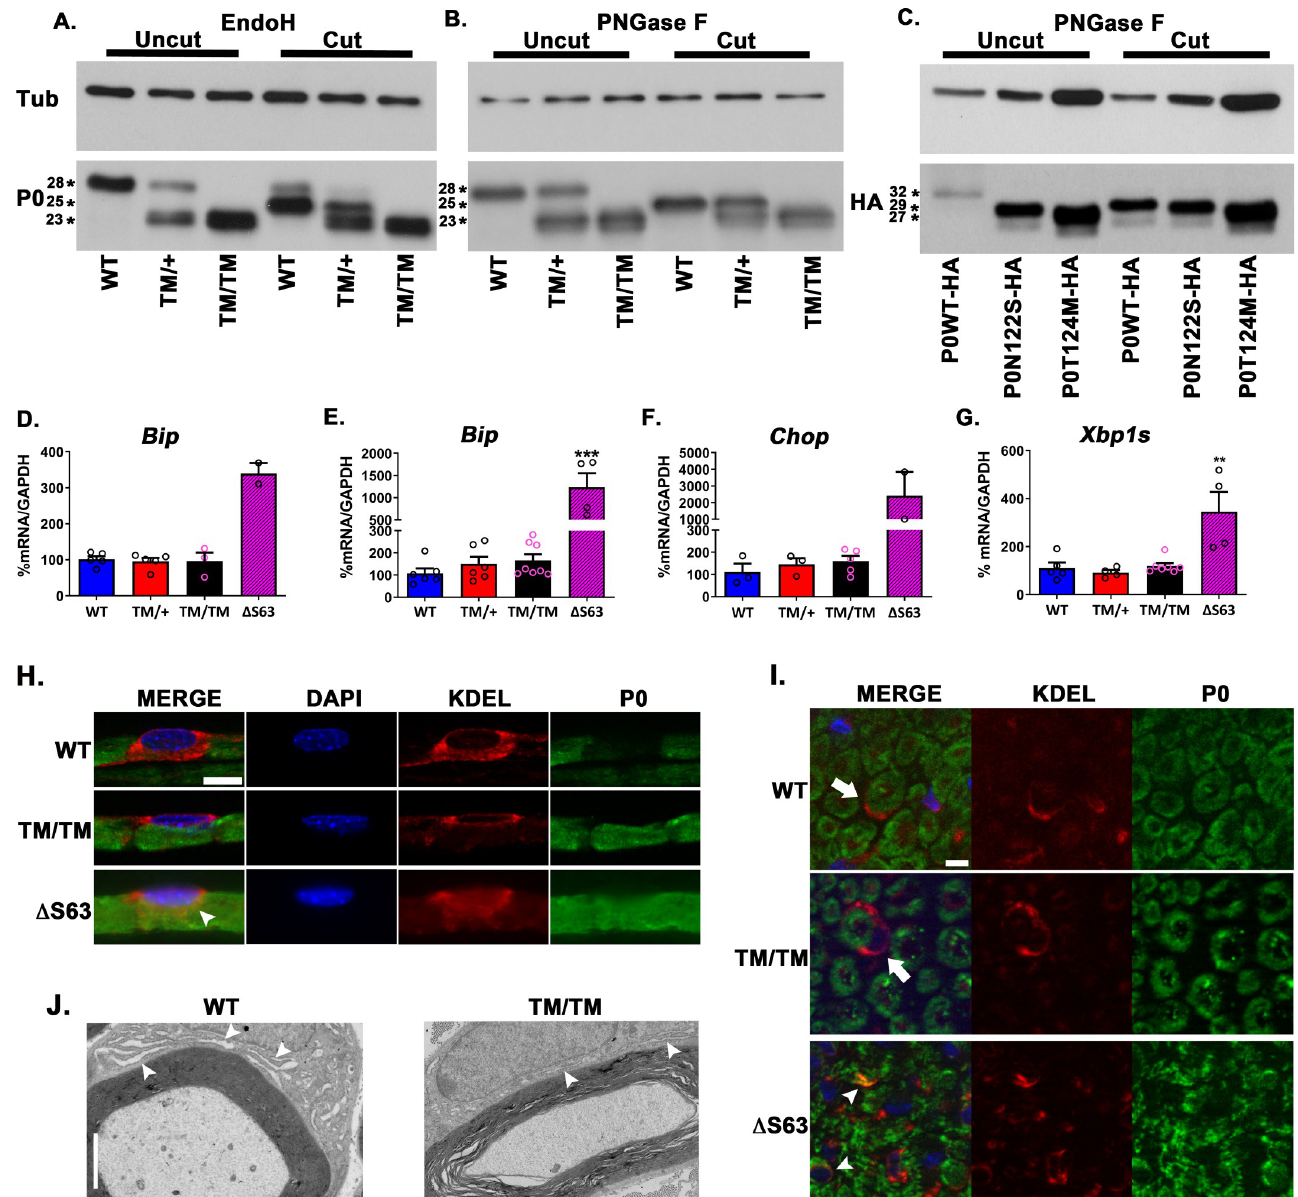
Fig 4. T124M mutation is responsible for molecular P0 modifications but does not alter P0 trafficking or UPR activation. Western blot analysis of P0 in sciatic nerve lysate from wild-type (WT), Mpz T124M/+ (TM/+), and Mpz T124M/T124M (TM/TM) mice treated with (cut) or without (uncut) EndoH ( A ) and PNGase F ( B ). ( C ) COS-7 cells were transfected with P0-HA, P0T124M-HA, or P0N122S-HA. Samples were treated with (cut) or without (uncut) PNGase F and blotted with antibodies against HA. β -Tubulin (TUB) was used as a loading control. Asterisks indicate relative molecular weight. Bip , Chop , and Xbp1 spliced mRNAs were measured at postnatal day 10 ( D ) and postnatal day 30 ( E, F, and G ) by RT-qPCR TaqMan assay. GAPDH mRNA was used for normalization. Δ S63 sciatic nerve mRNA was used as a positive control. One-way Anova [Bip P10: F (2, 10) = 0.07536, p = 0.9279; Bip P30: F (3, 20) = 20.72, p < 0.0001; Chop P30: F (2, 8) = 0.7230, p = 0.5145; Xbp1s P30: F (3, 16) = 9.800, p = 0.0007]. Representative immunofluorescence images of sciatic nerve teased fibers ( H ) and cross sections ( I ) at postnatal day 30 and 2 months of age, respectively. Fibers and cross sections were stained for P0 (green), endoplasmic reticulum (ER) (KDEL, red), and DAPI (blue). Note that P0T124M, like P0WT, is not retained in the ER and reaches the myelin sheath (arrows). P0 Δ S63 is retained in the ER (arrowheads) and does not reach the myelin sheath. ( J ) Representative electron micrographs of WT and Mpz T124M/T124M myelinating Schwann cell ER at 2 months of age. ER from Mpz T124M/T124M SC is not enlarged in comparison to ER from WT SC. Arrowheads indicate ER. Scale bars: 2 μ m. n (animals) � 3 per genotype. � p < 0 . 05 , �� p < 0 . 01 , ��� p < 0 . 001 by multiple-comparisons Tukey’s post hoc tests after one-way ANOVA. Graphs indicate means ±